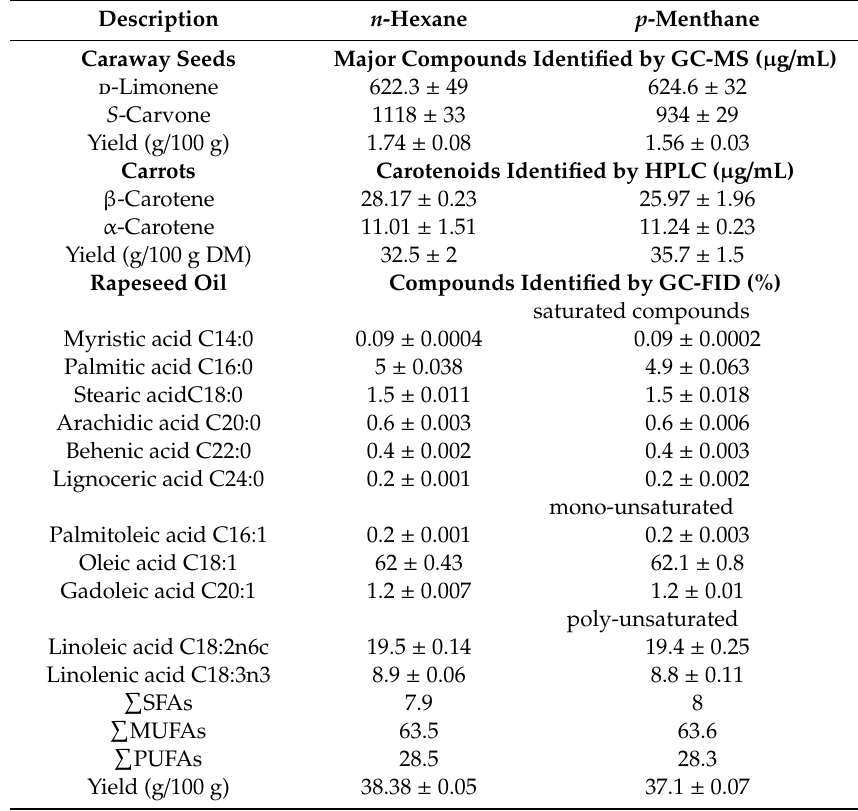
Table 1. Comparison of e ffi ciency using n -hexane and p -methane for extraction of secondary and to mass spectrometry; DM—dry matter; FID—flame ionization detector; SFAs—saturated fatty